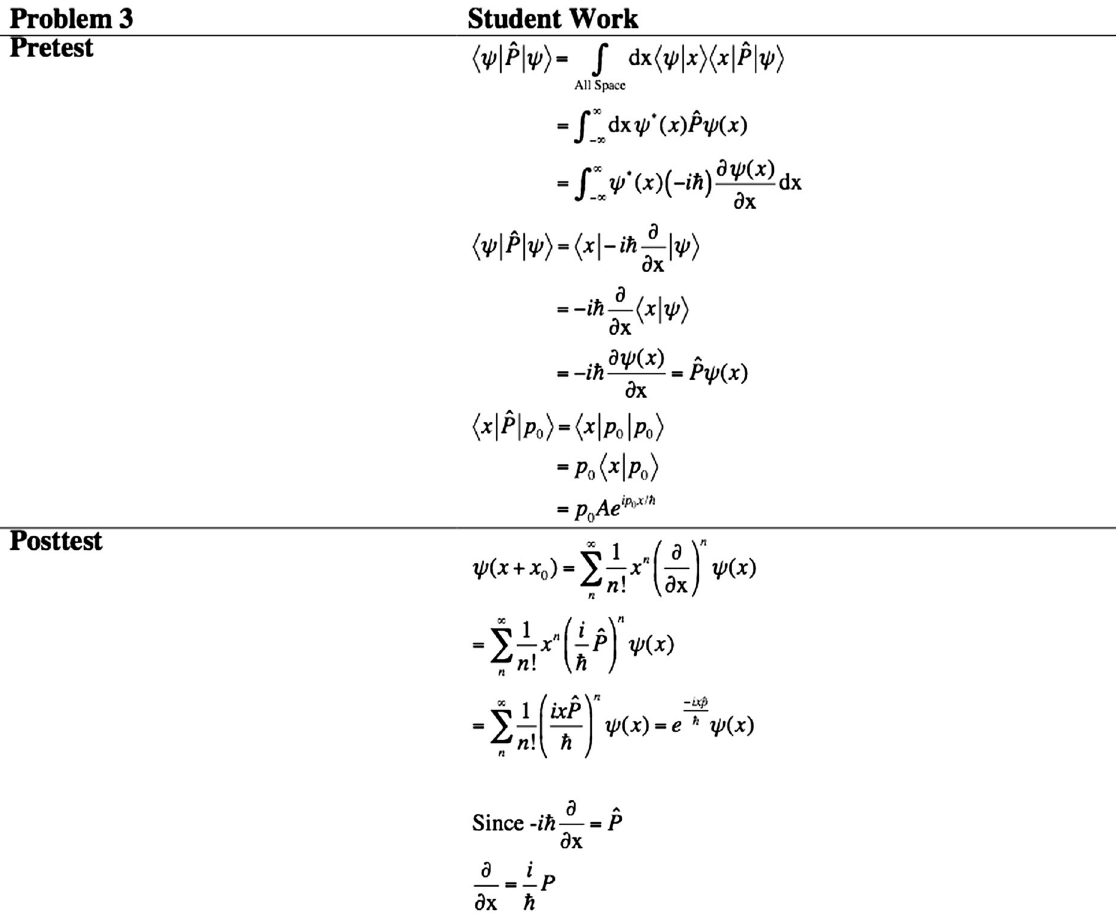
FIG. 9. An example of a pretest and posttest solution pair for a student from the incentivized group which demonstrates improvement in student understanding for the momentum problem. The pretest and posttest scores are 20% and 100% for invoking, 0% and 89% for applying, and 10% and 95% for the overall scores, respectively. The pretest shows exploratory derivations focused on expectation value of momentum that has nothing to do with the correct solution. The posttest solution is a succinct derivation of the desired